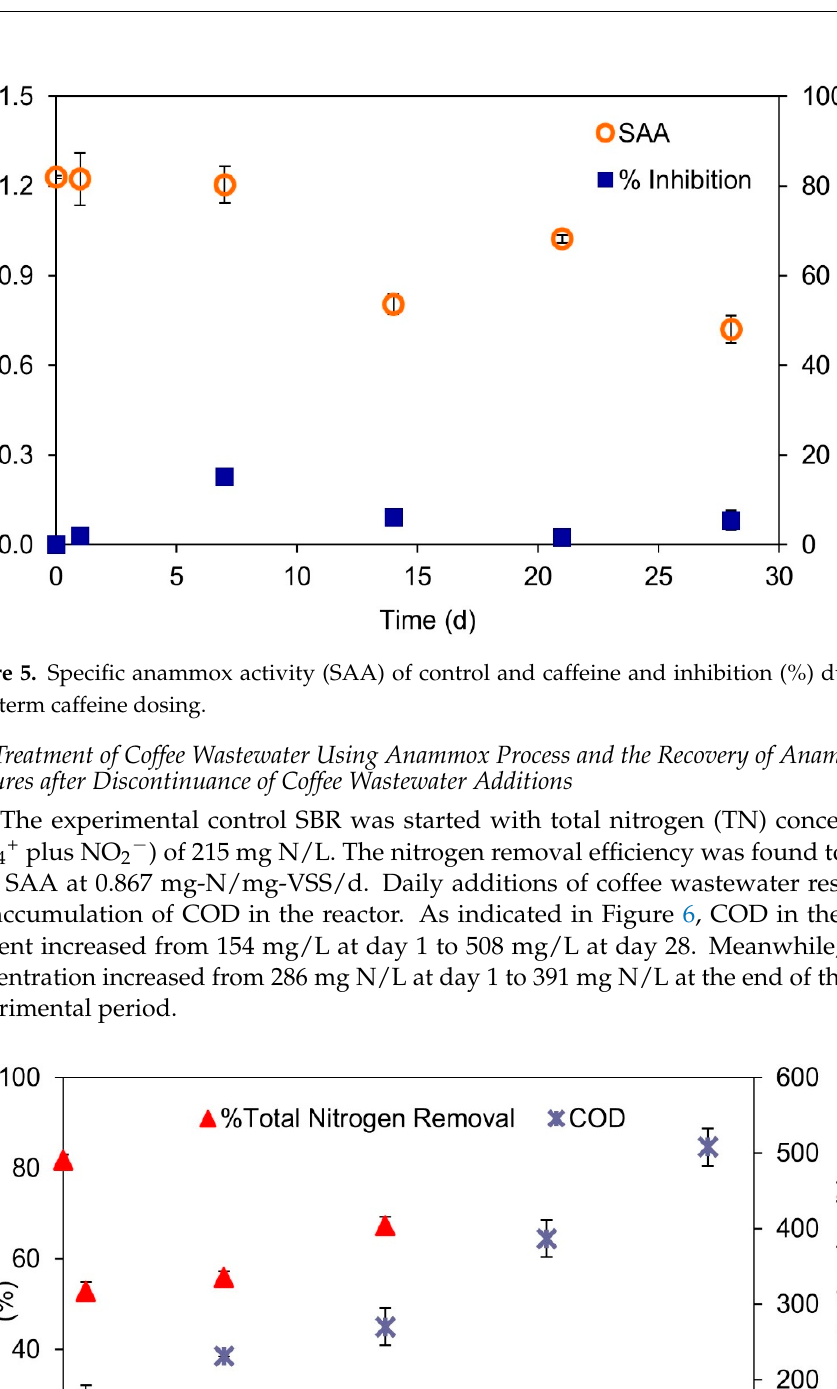
Figure 4. Nitrogen removal efficiency during long-term caffeine dosing.